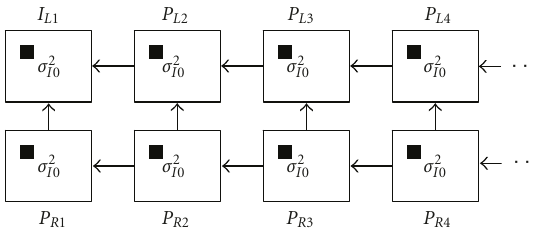
Figure 15: Propagation of an MB loss from I-frame. Figure 16: Propagation of an MB loss from